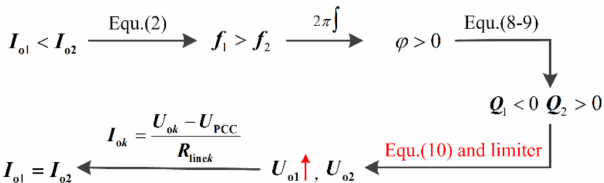
Figure 6. Reactive power-voltage feedback control process diagram with